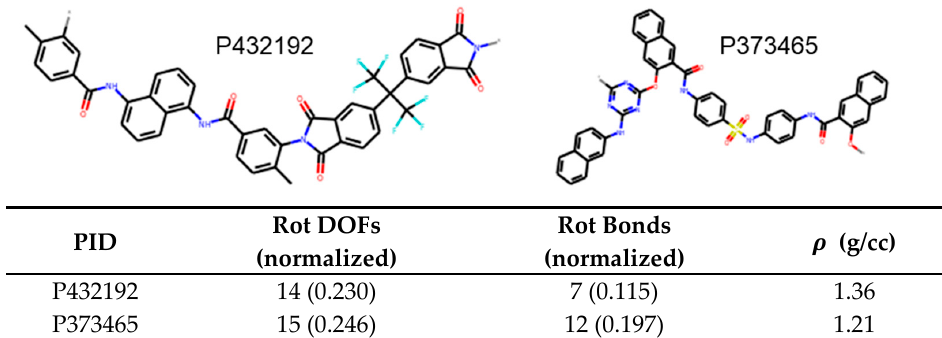
Figure 10. Example of two polyamides, with IDs P432192 and P373465, whose densities can be predicted using trend in rotatable bonds.